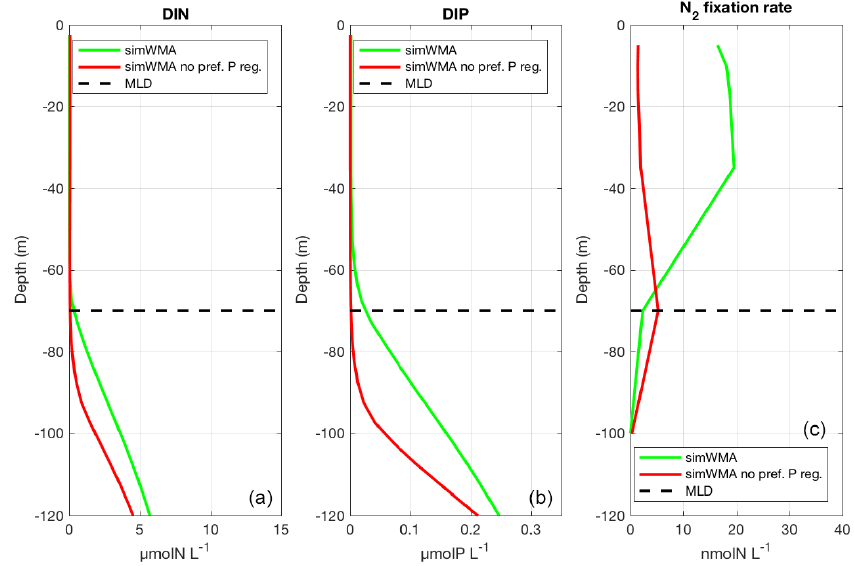
Figure 5. Vertical profiles of (a) dissolved inorganic nitrogen (DIN), (b) dissolved inorganic phosphorus (DIP), and (c) N 2 fixation rates for the simulation with diazotrophy, as a proxy of the WMA region (sim WMA ) with the preferential P regeneration (in green) and without the preferential P regeneration (in red). The horizontal black dashed line represents the depth of the maximum mixed layer calculated at 70m